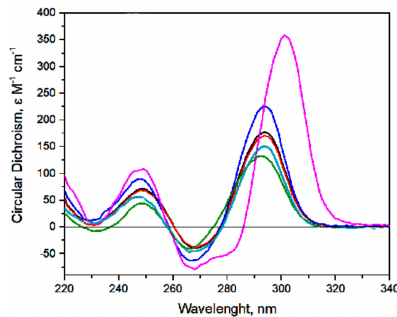
Figure 1. CD spectra of 2.5 µ M biHD1 and ODNs under the study in 10 mM NaH 2 PO 4 / Na 2 HPO 4 , 10 mM KCl, 140 mM NaCl, pH 7.5 at 20 ◦ C; biHD1—blue line, biHD1-C3—black line, biHD1-T4A,T20A—red line, biHD1-5’- ∆ 2G—green line, biHD1 + Ba—purple line, HD1—light blue